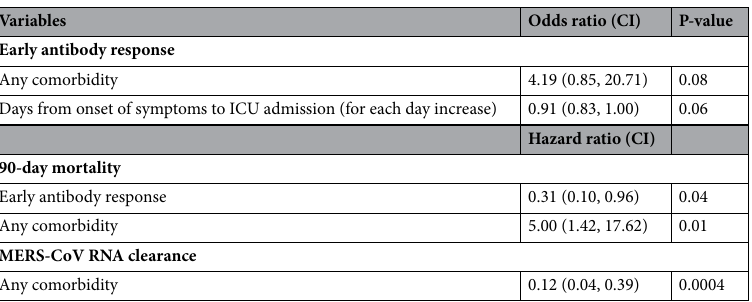
Figure 2. ( A ) Time to survival for critically ill patients who had an early antibody response (Day1-3) and those with delayed or absent response (censored at hospital discharge and at day 90, whichever comes first). ( B ) Time to clearance of the Middle East respiratory syndrome coronavirus (MERS-CoV) RNA from respiratory specimens as tested by the real-time reverse transcription polymerase chain reaction (rRT-PCR) among patients with early antibody response (Day1-3) and those with delayed or absent response. Variables Odds ratio (CI)